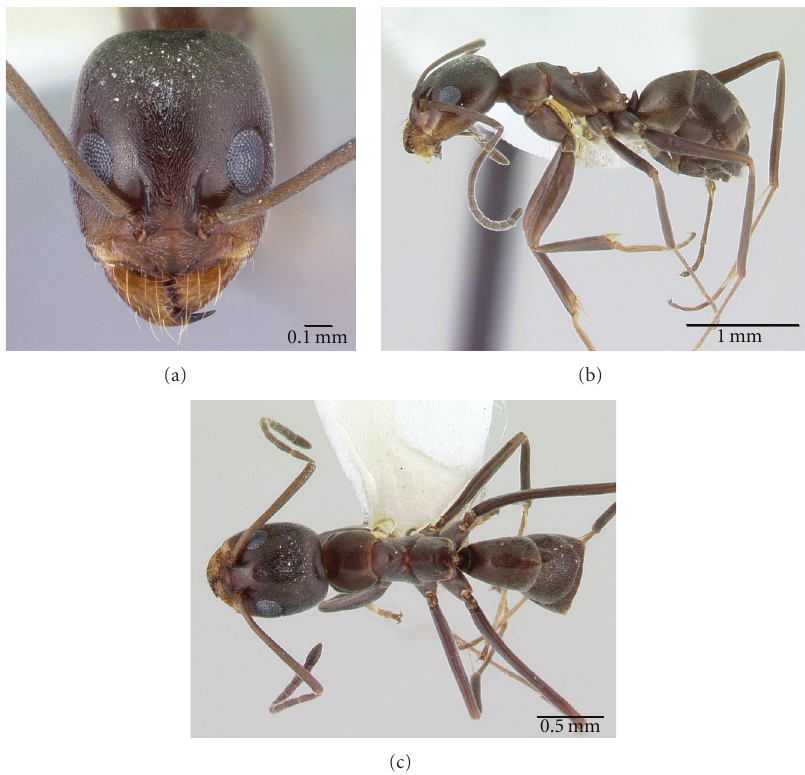
Figure 11: Dorymyrmex tuberosus n. sp. worker. holotype. (a) Head in full-face view; (b) body in lateral view; (c) body in dorsal view (CASENT0179518). Pictures and labels of localities of each photographed specimen are available at http://www.antweb.org/.